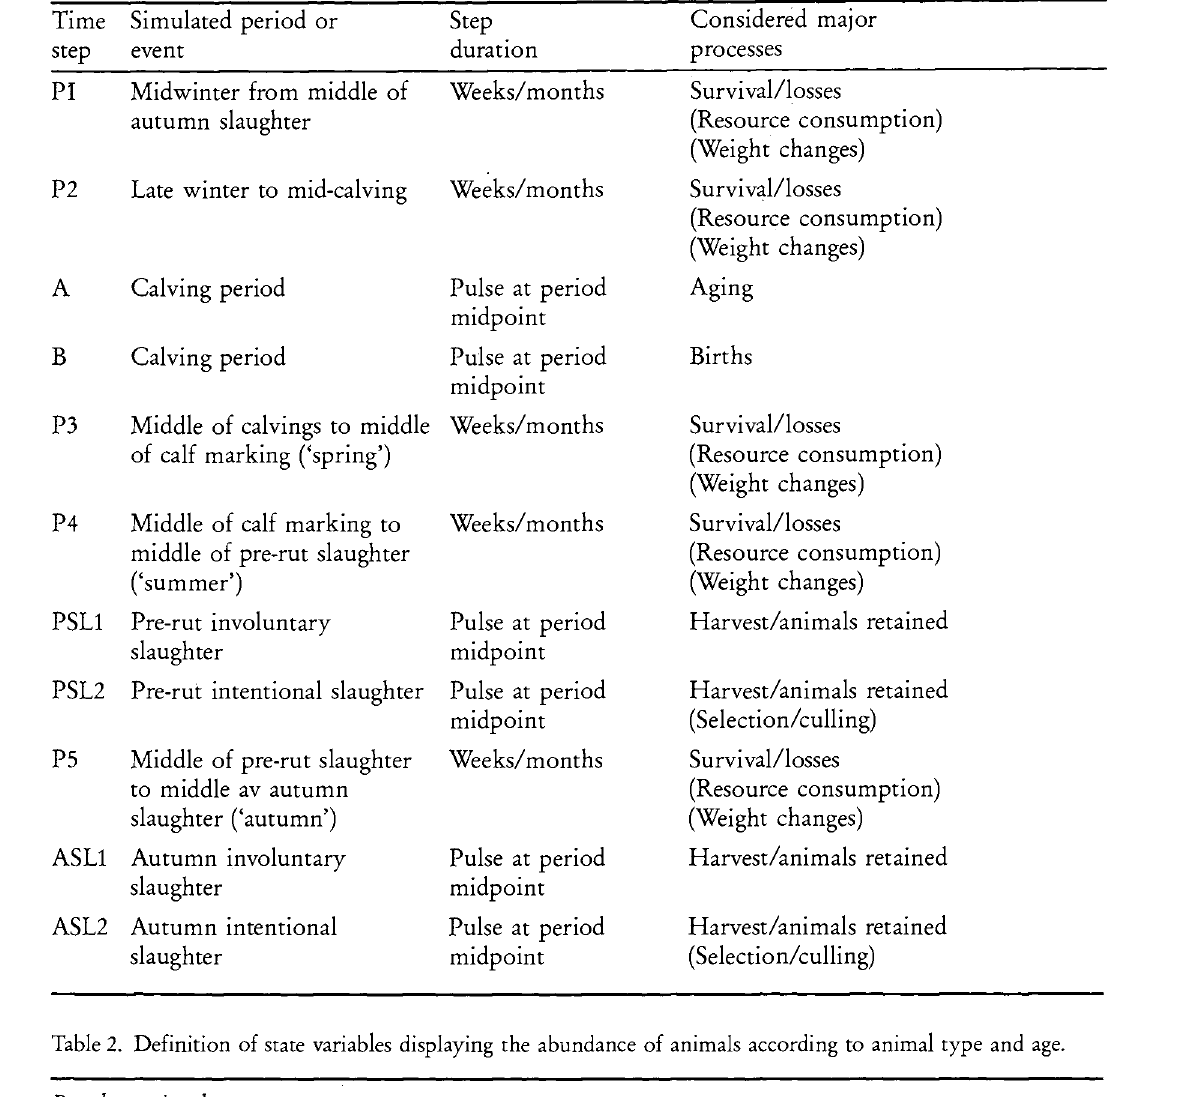
Table 2. Definition of state variables displaying the abundance of animals according to animal type and age. Regular animal